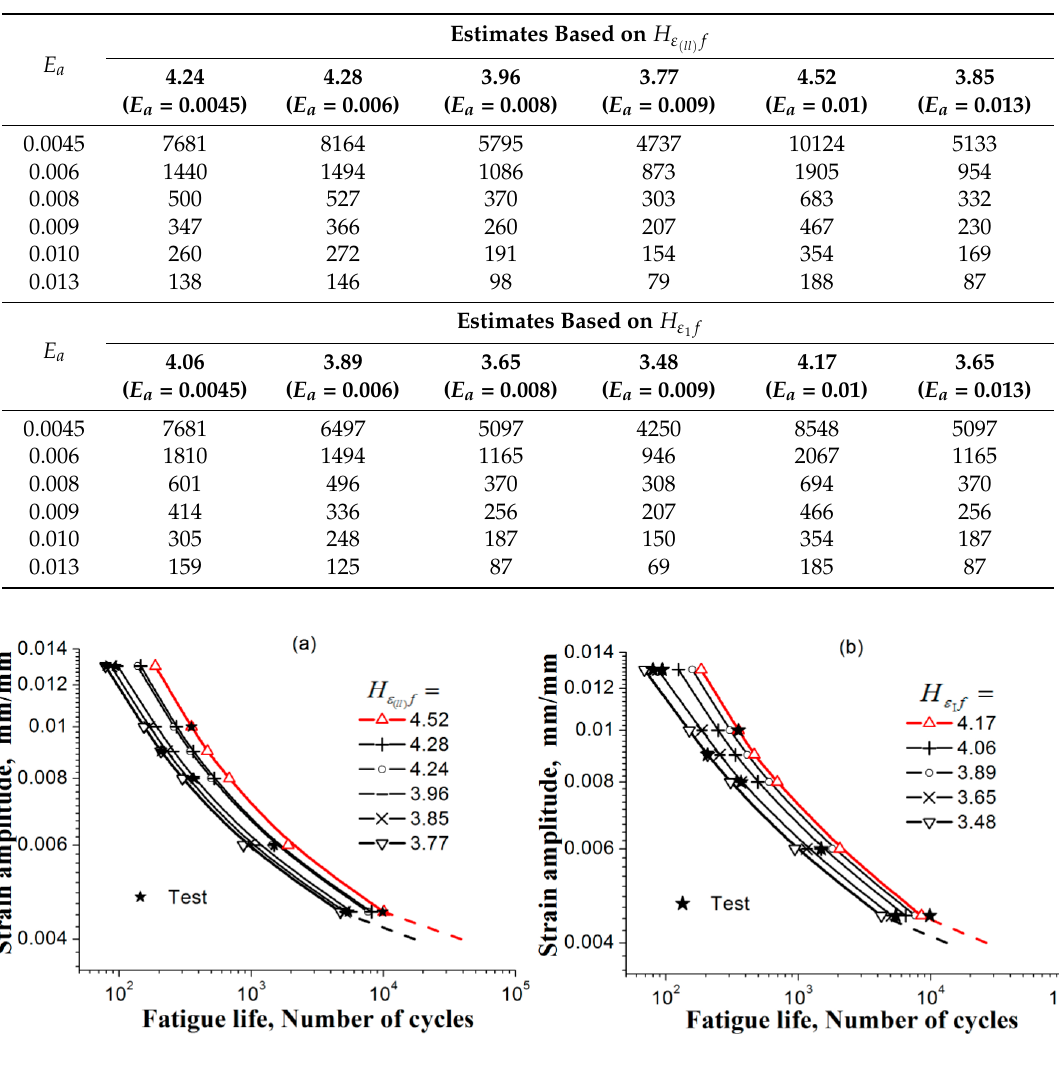
Figure 9 The predicted-life curves ( ~ ) a f E N of the material GH4169 at temperature 650 °C Figure 9. The predicted-life curves ( E a ∼ N f ) of the material GH4169 at temperature 650 ◦ C based on ( a ) H ε and ( b ) H ε . The test data in these figures are cited from literature [9] (see Table H H ( ll ) f I f based on ( a ) f ε and ( b ) f ε . The test data in these figures are cited from literature 54 (see ll )( I